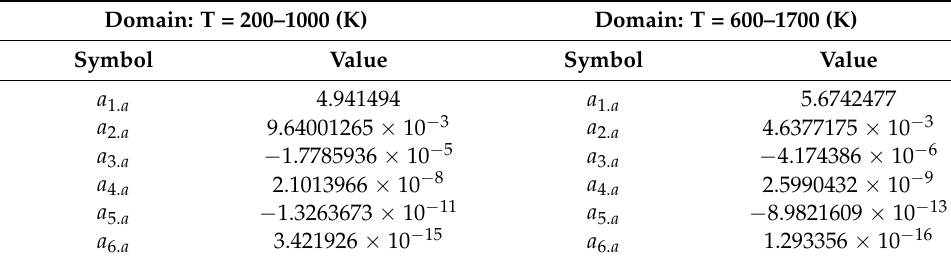
Table 2. Air entropy polynomial